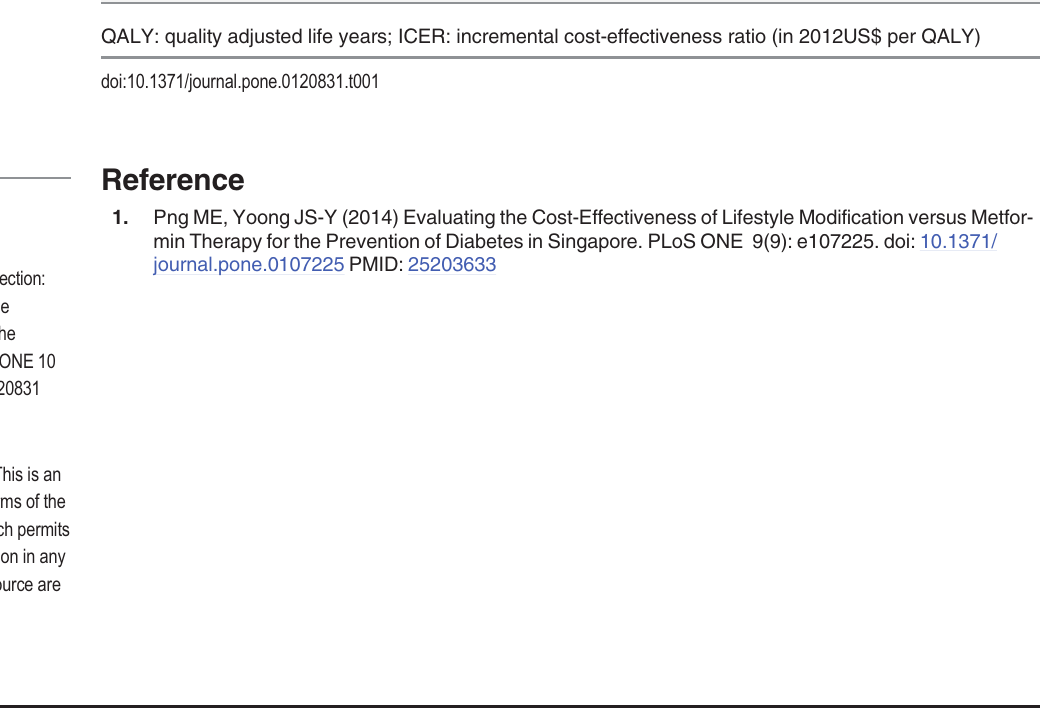
ICER of metformin intervention